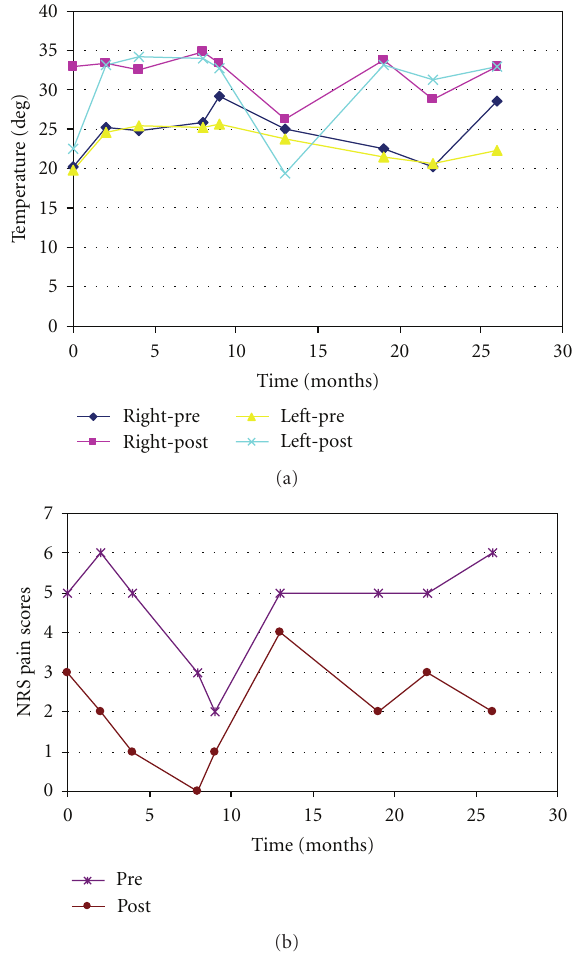
Figure 2: Sympathetic block-induced changes in temperature and NRS pain scores. (a) The peak temperatures, monitored at the plantar surface of the toes with an electronics device, increased significantly in both sides after bilateral lumbar sympathetic blocks (post) compared to the baseline values taken before the blocks (pre). (b) The NRS pain scores, evaluated in the preprocedure room before the blocks (pre) and in the recovery room after the block (post), decreased significantly after each lumbar sympathetic